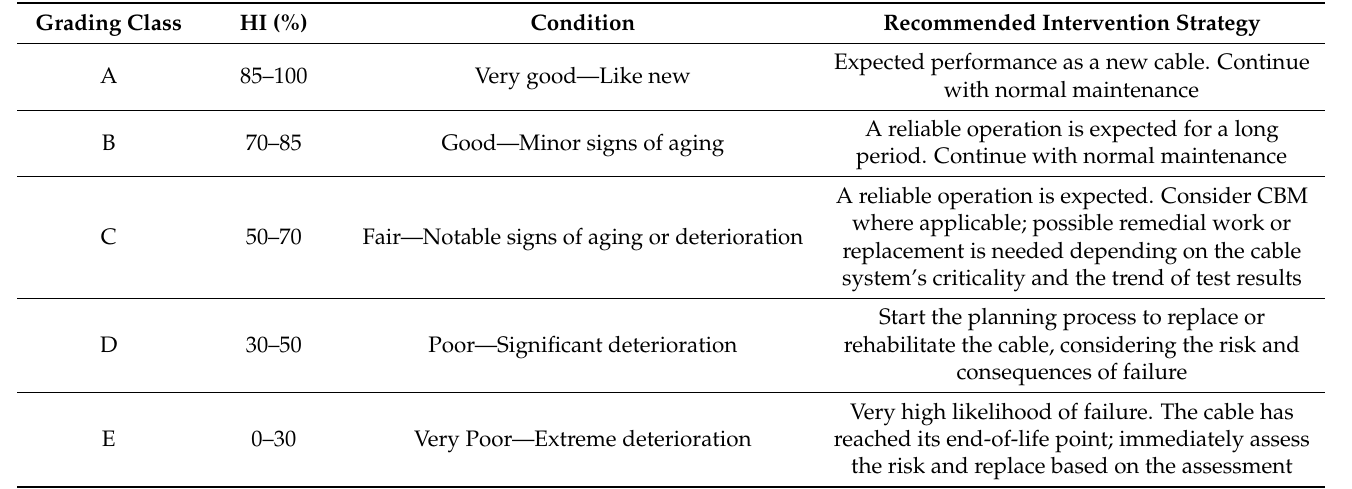
Table 1. Recommended intervention strategies for UGPCs, based on HI